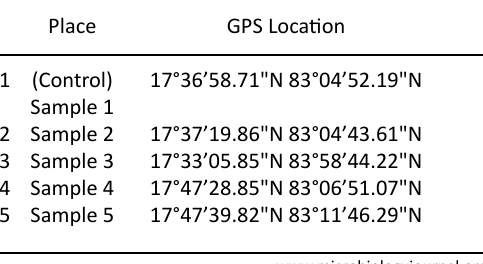
Table 1. GPS Location of the soil samples collected